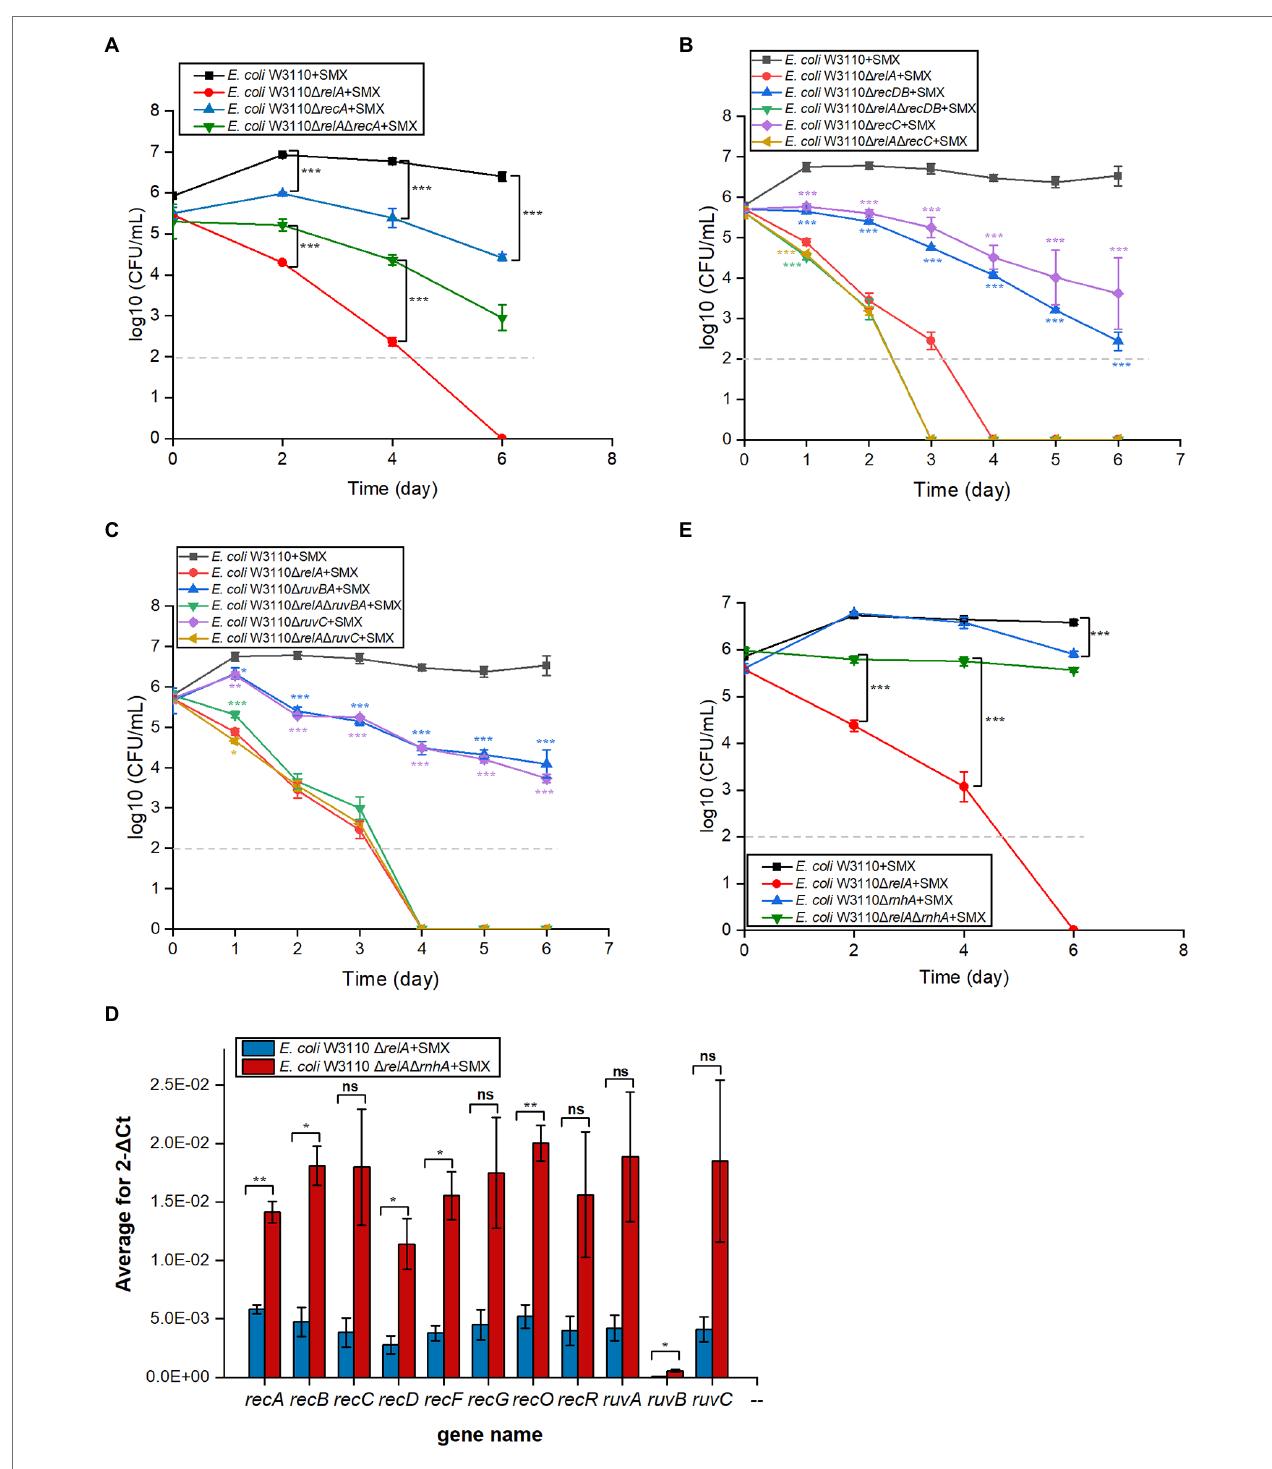
FIGURE 4 | Disruption of the DNA DSB repair system leads to significantly decreased viability in E. coli and E. coli Δ relA upon SMX treatment. (A–C) Homologous recombination repair mediates the bactericidal effect of SMX (10 μ g/ml). (D) Expression levels of homologous recombination repair genes in the ∆ relA and ∆ relA ∆ rnhA mutants (RT-PCR). (E) Deletion of rnhA reverses the bactericidal effect of SMX on the ∆ relA mutant. Dashed gray lines represent the limit of detection. Error bars represent the standard deviation. In panel (B,C) , single gene mutant was compared with wild type, while double gene mutant was compared with ∆ relA ; asterisks of the same color as the line indicate the statistical difference between the strain represented by the line and the control with SMX treatment ( p > 0.05 is not shown). Statistical analysis was determined by unpaired two-tailed Student’s t test (* p ≤ 0.05, ** p ≤ 0.01, *** p ≤ 0.001; ns, not